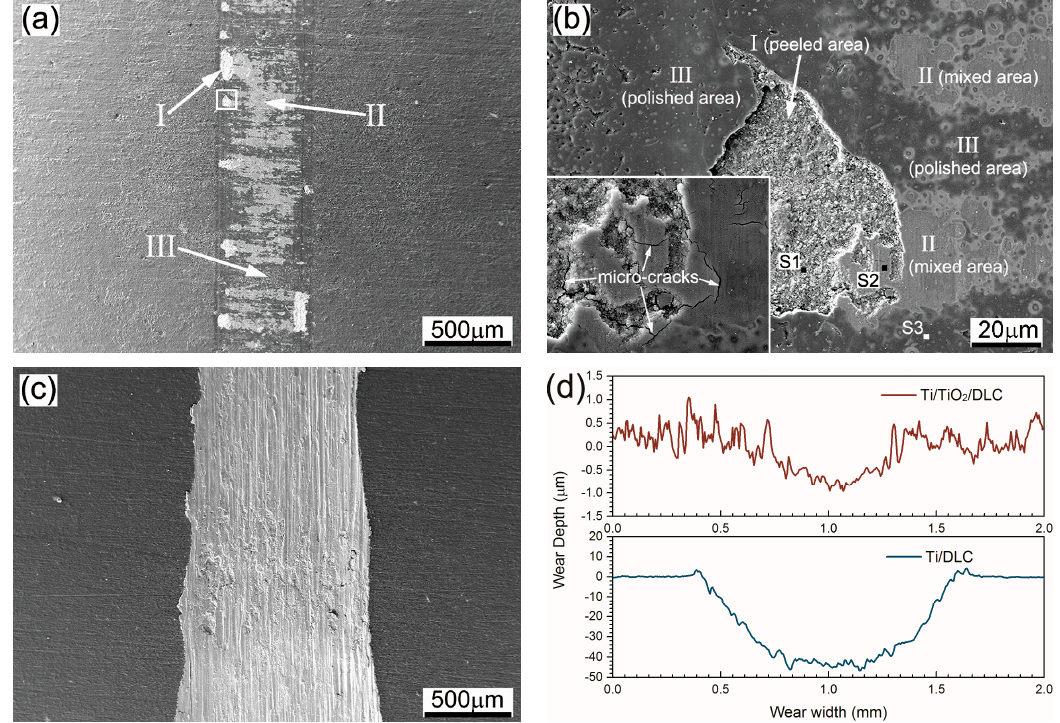
Figure 6. SEM images and cross-sectional profiles of wear tracks after a sliding distance of 1000 m under normal load of 10 N: ( a ) Ti/TiO 2 /DLC sample; ( b ) the enlargement of three kinds of typical morphologies of Ti/TiO 2 /DLC sample wear track; ( c ) Ti/DLC sample; ( d ) cross-sectional profiles of wear tracks. Table 1. The element composition of wear track of the Ti/TiO 2 /DLC sample.